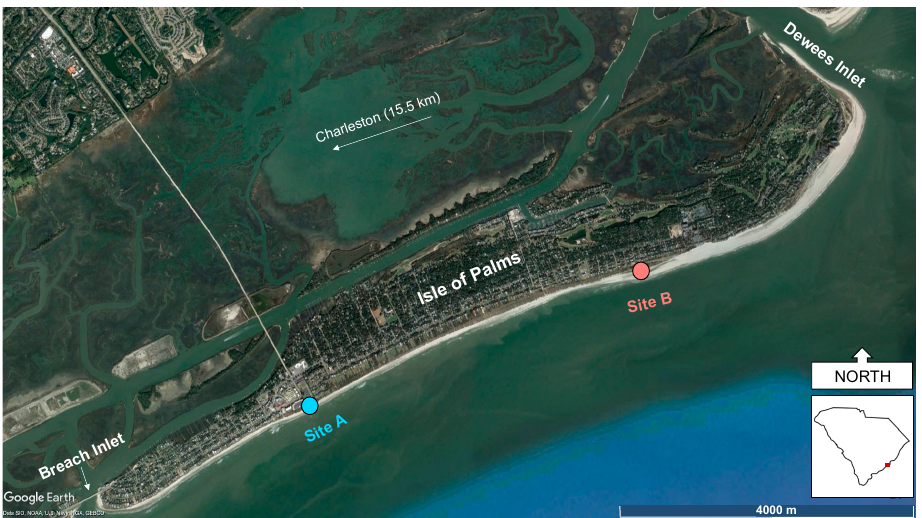
Figure 1. Study area located on Isle of Palms, SC, USA. The blue and red dots indicate Site A at Pavilion Drive and Site B at 53rd Avenue, respectively. The inset map shows the location of Isle of Palms within SC (red box). Base imagery obtained from Google Earth from September 2018.